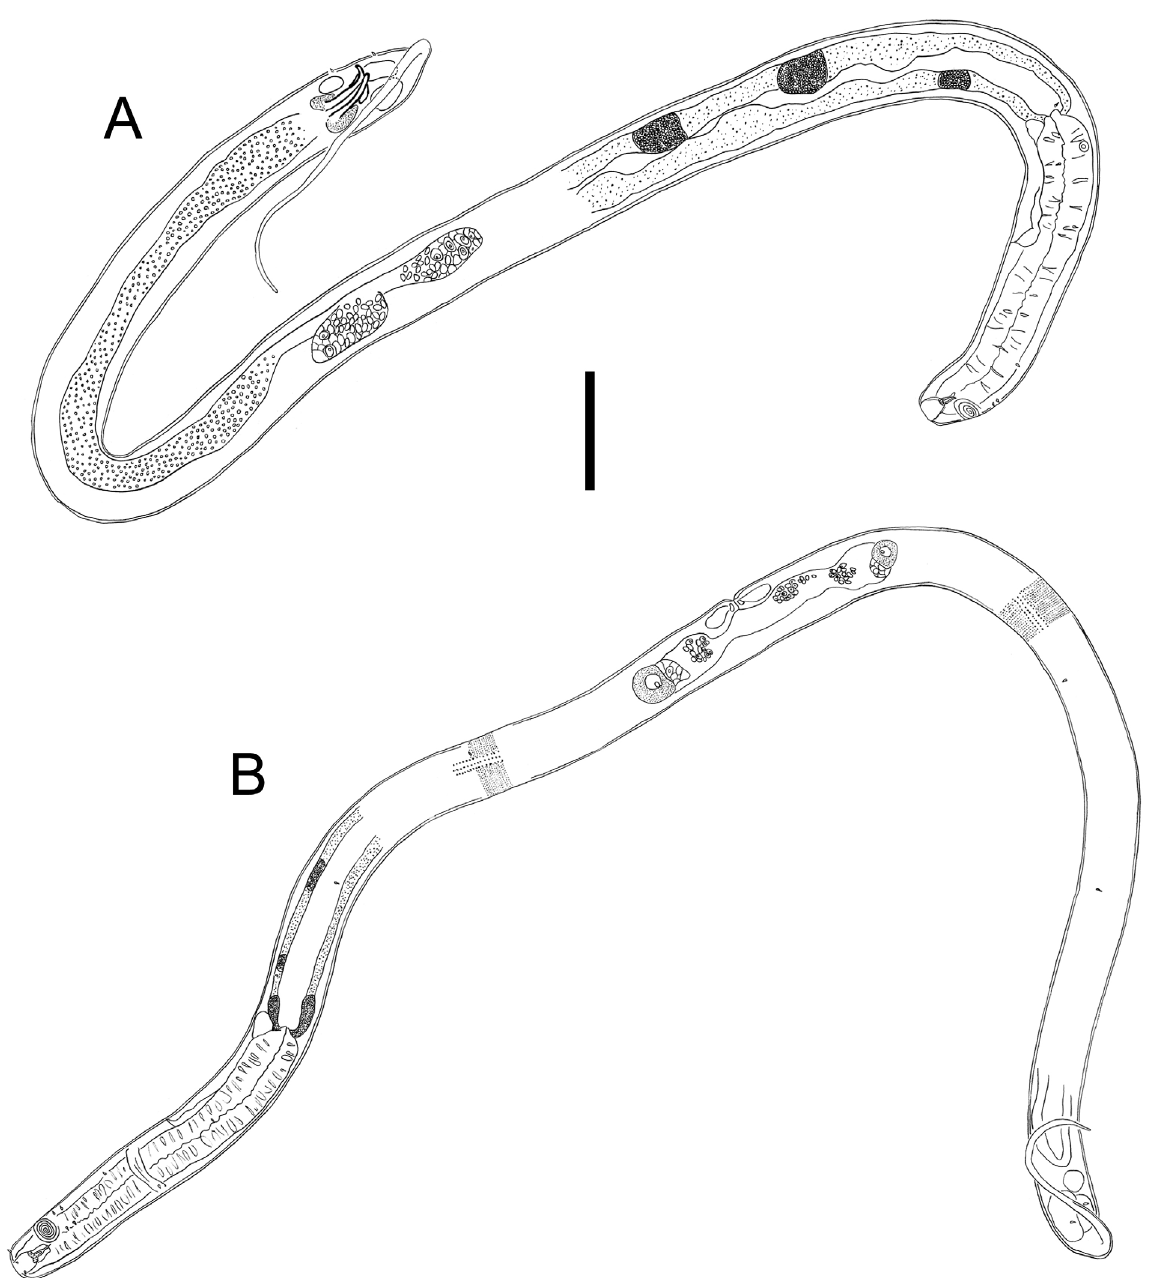
Fig. 15. Bendiella thalassa gen. et sp. nov. A . Entire male. B . Entire female. Scale bar = 50